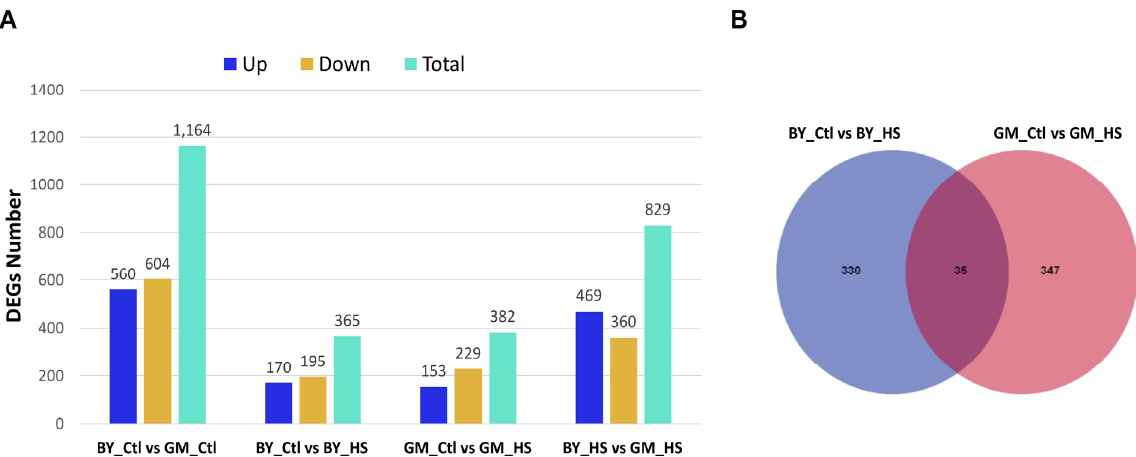
Figure 2. Identification of Differential Expressed Genes (DEGs) in BY and GM chickens. ( A ) Summary of total DEGs between BY and GM in response to heat stress ( p < 0.05 was used to determine significant DEGs). ( B ) Venn diagram showing the number of unique and shared DEGs between BY and GM in response to heat stress. BY_Ctl: Beijing You control group, GM_Ctl: Guang Ming control group, BY_HS: Beijing You heat stress group, GM_HS: Guang Ming heat stress